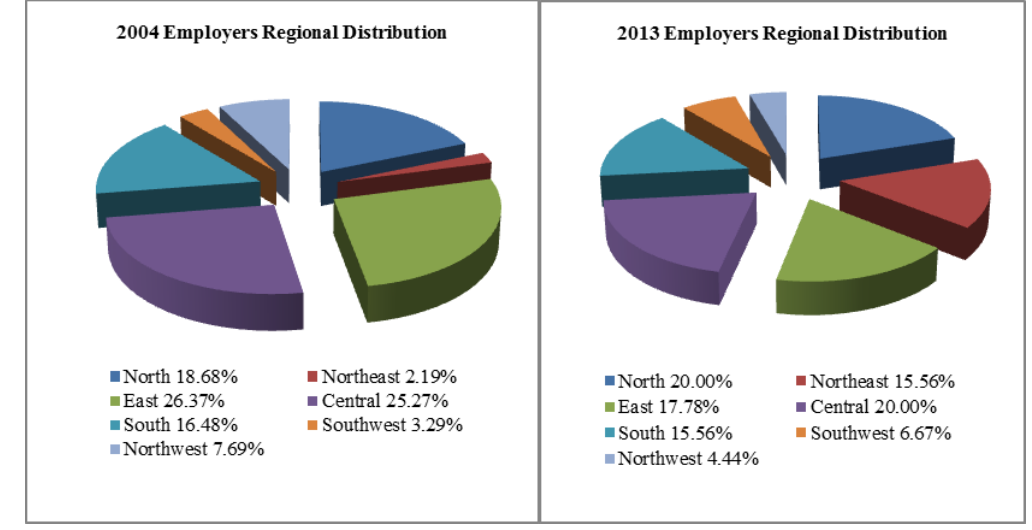
Figure 6. 2004/2013 Regional Distribution o f